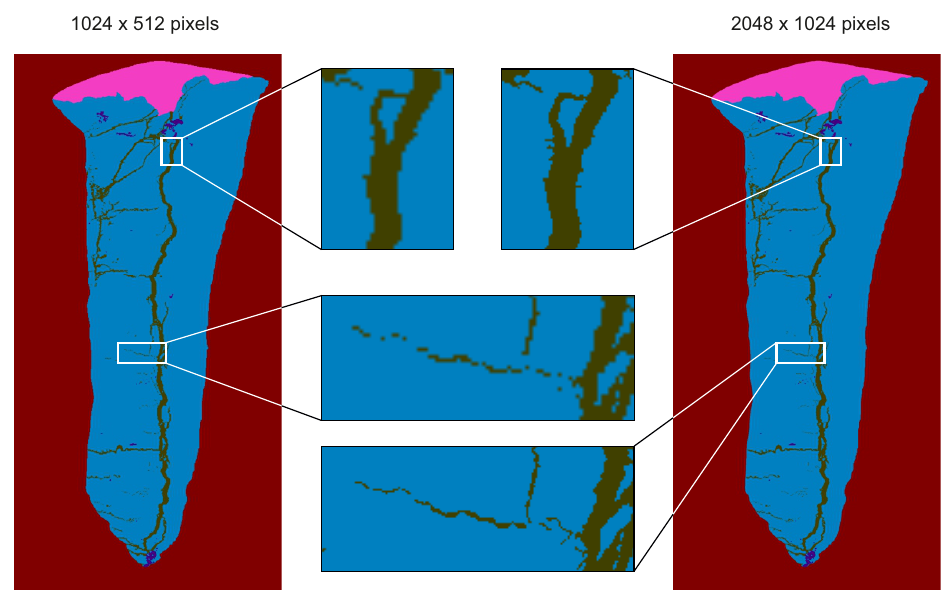
Figure 7. Comparison of prediction results with different image resolutions.